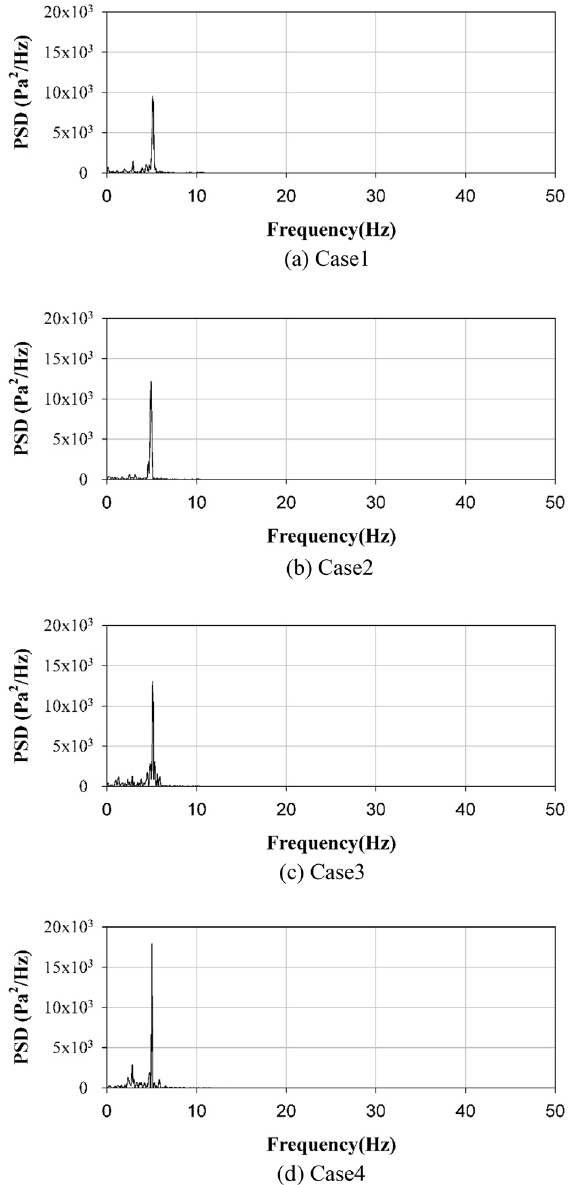
Figure 10. Power spectral density of pressure fluctuation for different shapes of fluidized bed